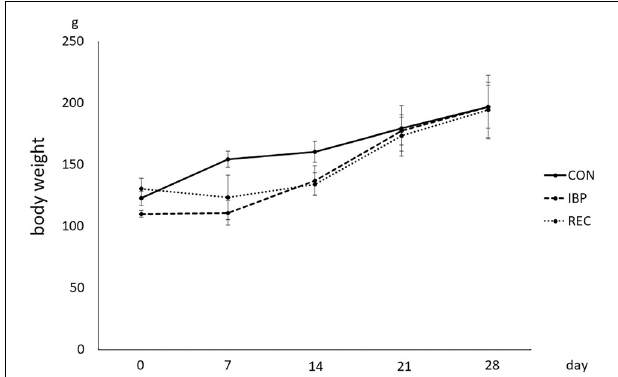
FIGURE 3 | Hematoxylin-eosin staining of SMG at × 400 magnification with an optical microscope. Morphological observation of HE staining of the SMG in the CON group (A,B) , IBP group (C,D) , and REC group (E) . The IBP group at 14 days (C) showed an enlargement of the acini. At 28 days, the size of the acini decreased (D) compared to the size at 14 days. (E) In the REC group at 14 days, the size of the acini was approximately the same as that of the CON group (E) . H&E, hematoxylin and eosin; CON, control group; IBP, incisor bite plate group; REC, recovery group. Bar = 25 µ m, × 400